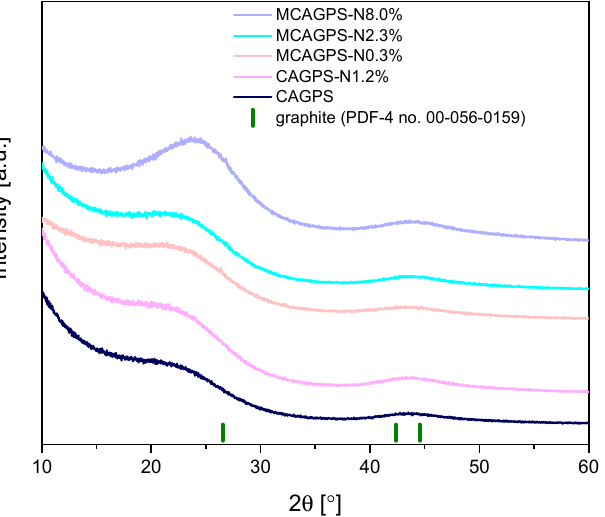
Figure 1. XRD patterns of nitrogen-doped and pristine carbon aerogels over the 2 θ range of 10–60° (MCAGPS—carbon aerogel made from potato starch modified with melamine; CAGPS-N—carbon aerogel made from potato starch modified by N 2 pyrolysis; CAGPS—pristine carbon aerogel)